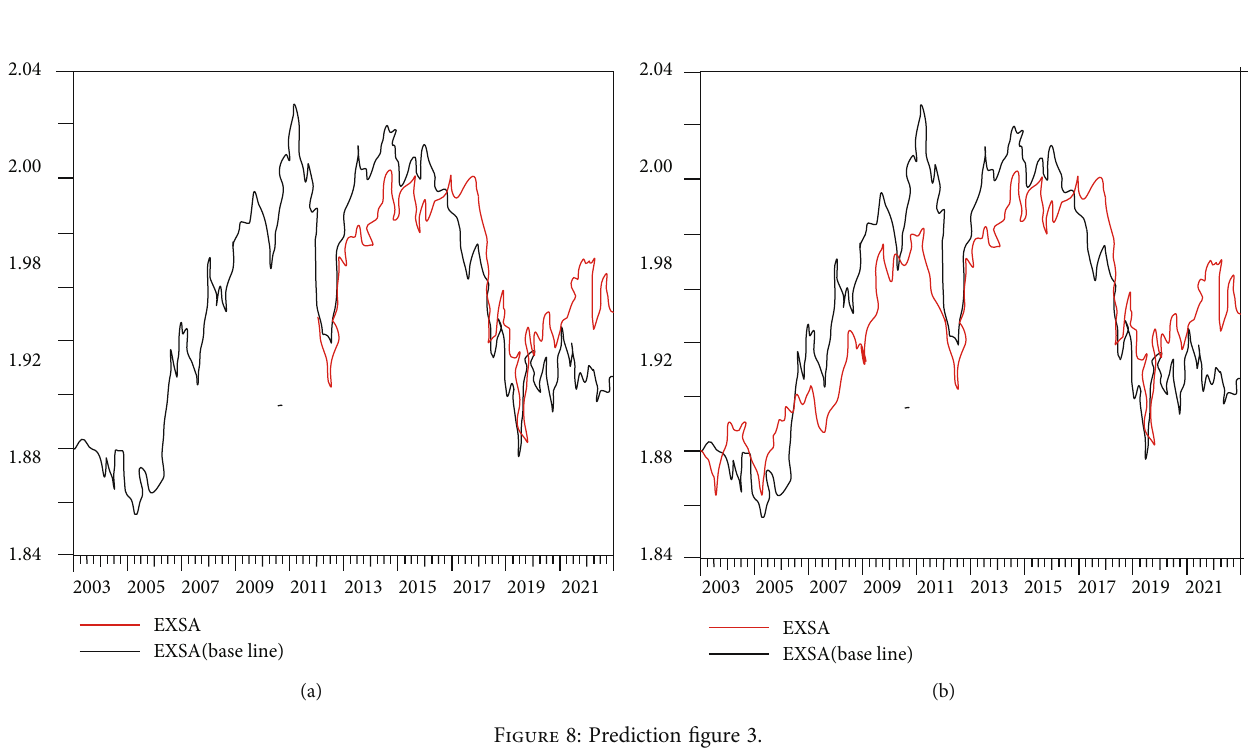
Figure 7: Prediction fi gure 2.